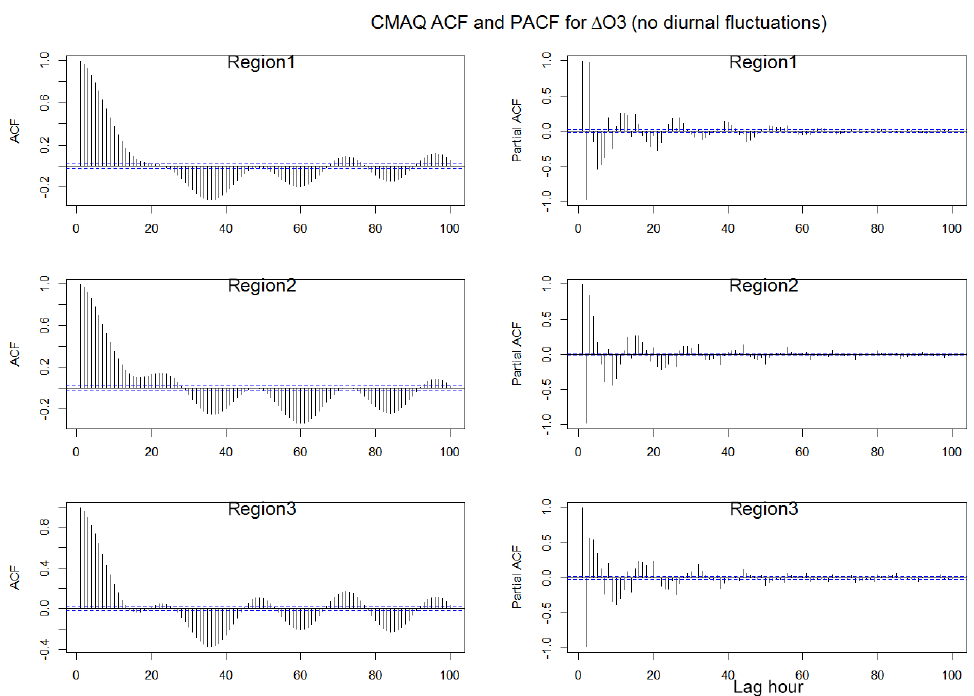
Figure 21. As in Fig. 20 for the differenced time series of residual of ozone obtained by filtering out the diurnal fluctuations from the modelled and observed time